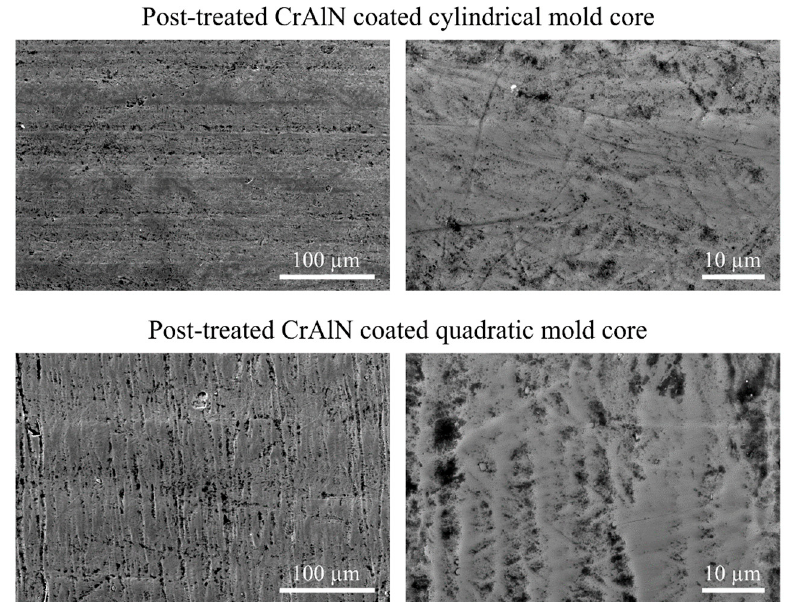
Figure 14. SEM micrographs of the post-treated core’s surfaces with a cylindrical and quadratic geometry.